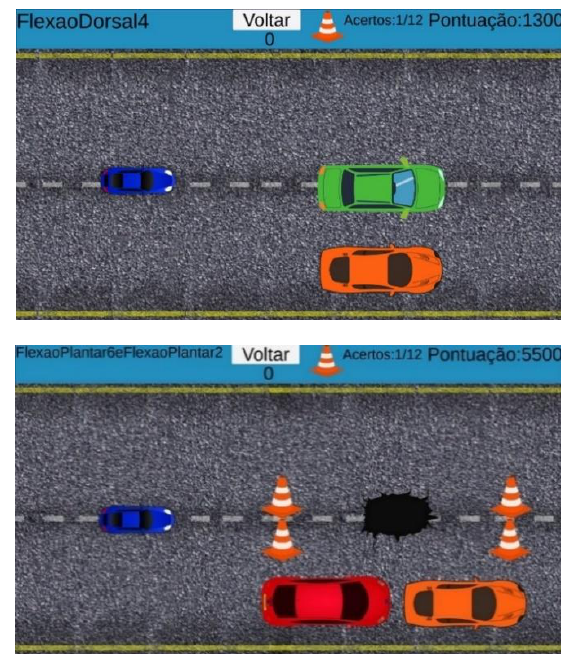
Figure 3. Acelera Game scenario